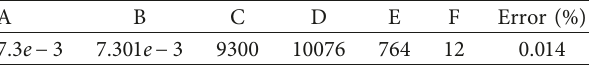
Table 5: Summaries of the asphalt mastic and voids. A